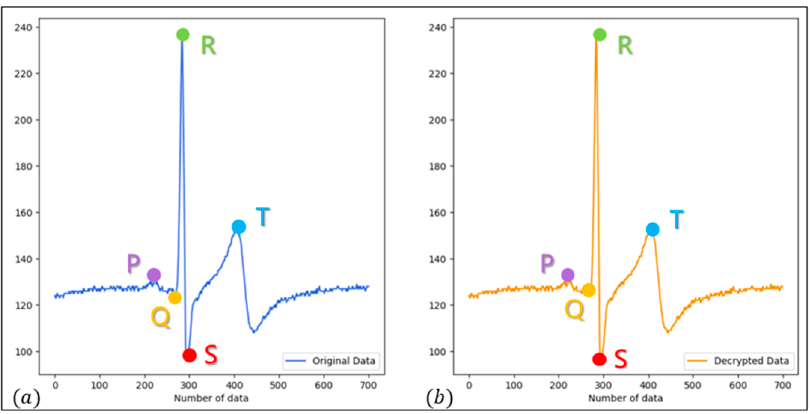
Figure 16. Simulation results of ECG. ( a ) The original data; ( b ) Encrypted data; ( c ) Decrypted data; ( d ) The error between the original data and decryted data.